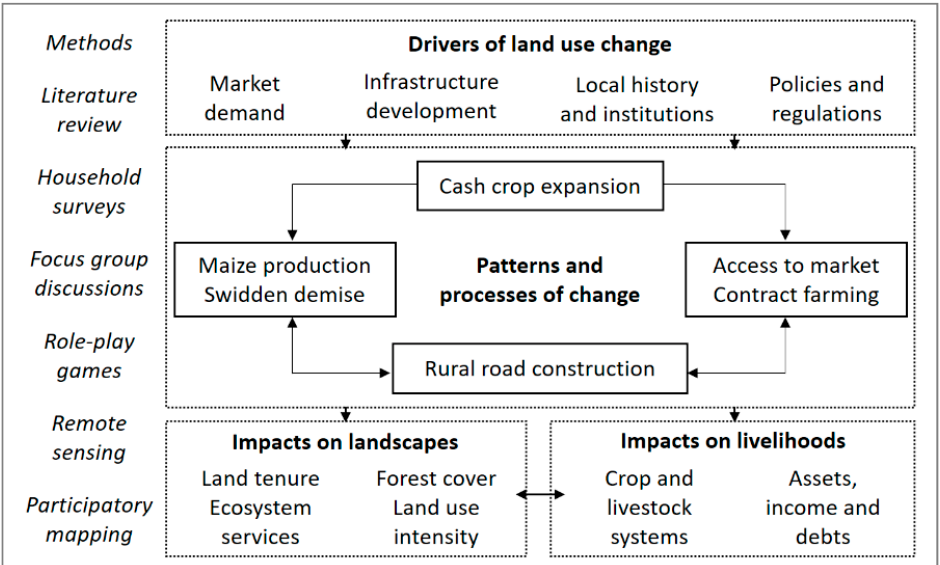
Figure 2. Methodological